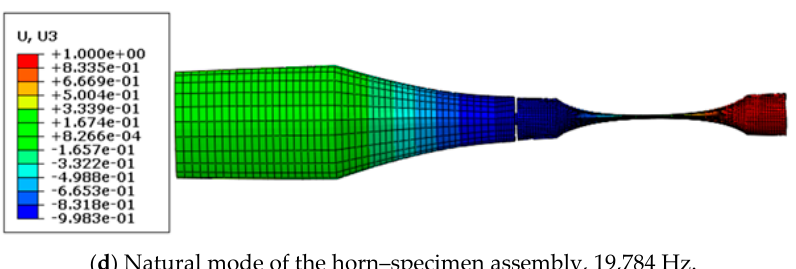
Figure 3 . Modal analysis of the specimen and horn using the finite element method.